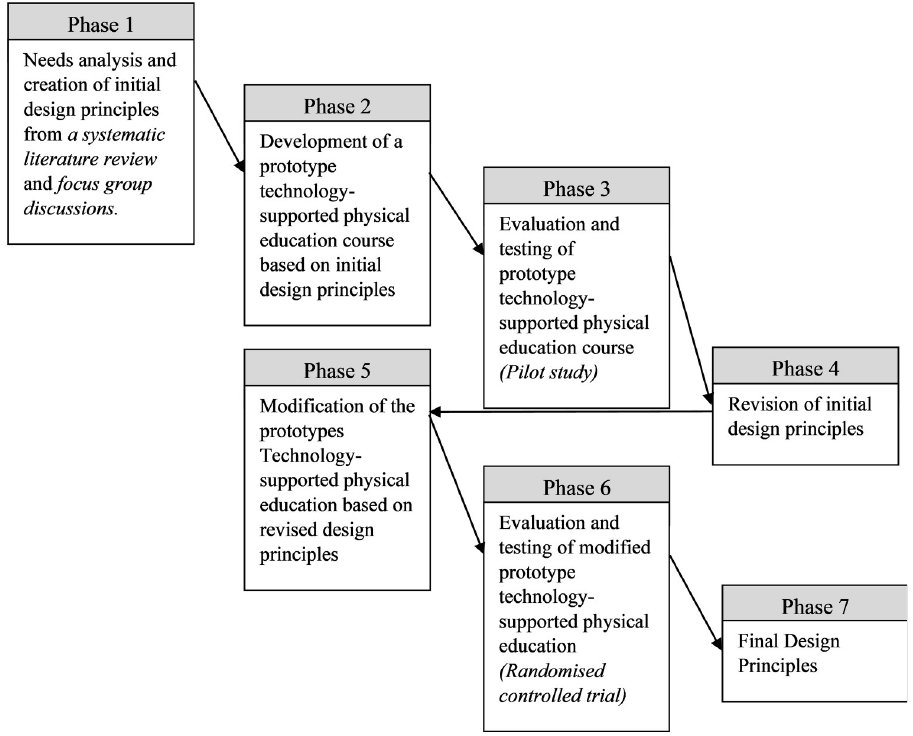
Fig 2. Diagrammatic overview of how design-based research methodology informed this research project. The four studies are identified in italics.